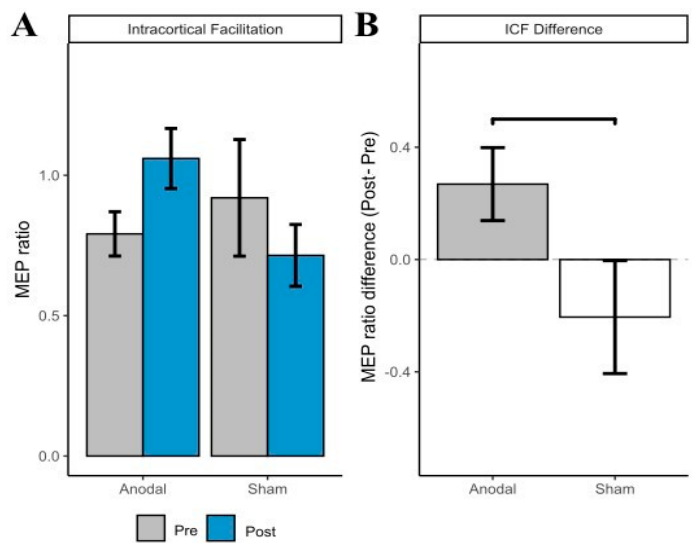
Figure 2. ( A ) Intracortical facilitation (ICF) motor evoked potential (MEP) amplitude (with standard error of the mean error bars) at pre ‐ and post ‐ intervention by group. ( B ) ICF difference score (Post ICF MEP amplitude—Pre ICF MEP amplitude; with standard error of the mean error bars) by